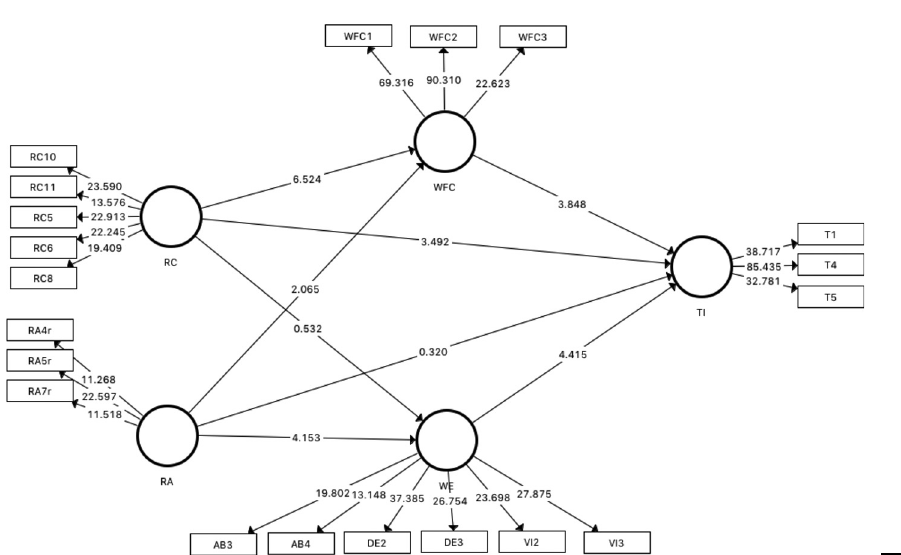
Figure 2. Research